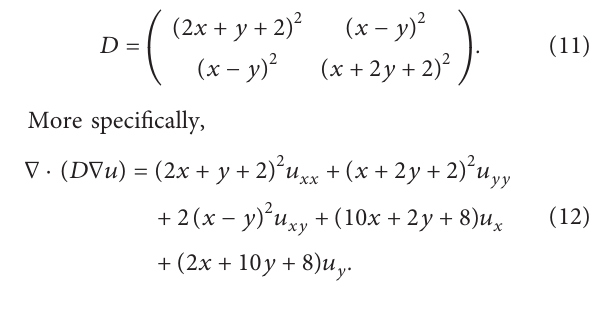
Figure 3: RMSEs for field solution versus the collocation number M .